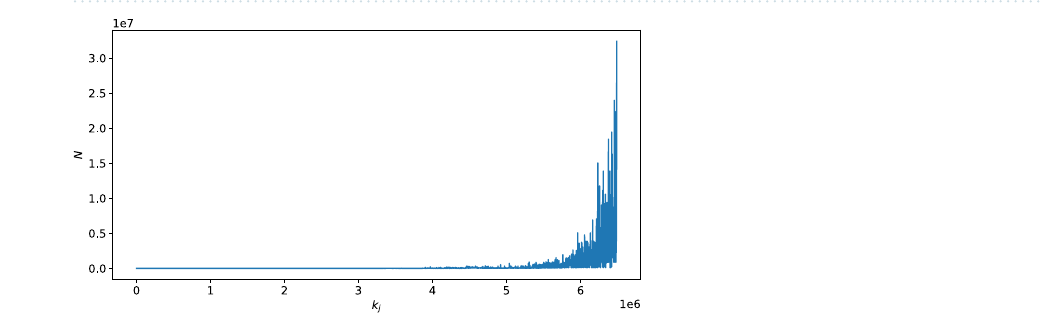
Figure 4. Social welfare associated with Nash equilibria found in different sets of simulations. We do not include the point when K = 0 in the figure, as the social welfare is always 0. K represents the number of players who use the TPI services. The social welfare for the extreme Nash equilibrium K = p is always greater than the social welfare for interior Nash equilibria. The equilibrium in which no one joins ( K = 0 ), however, always has the highest social welfare.